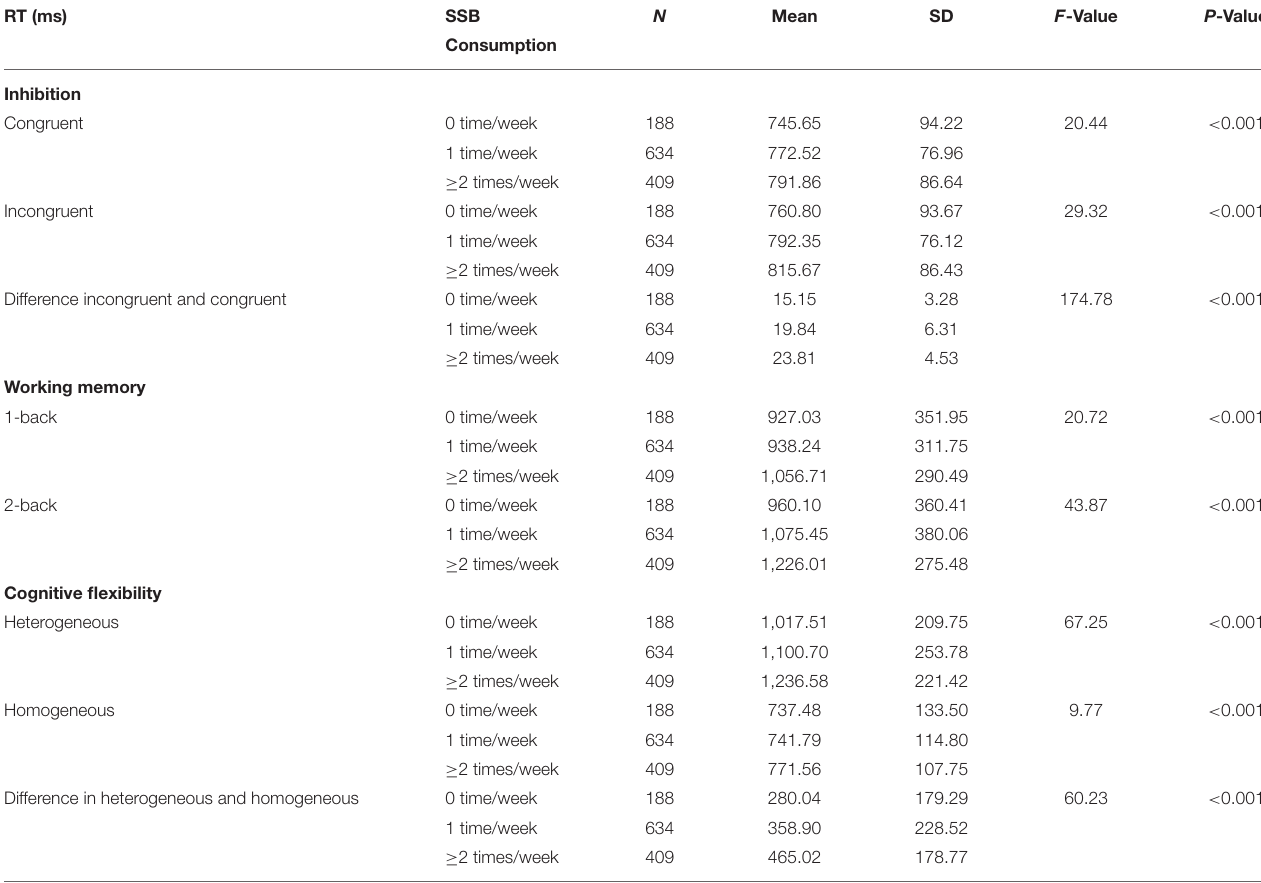
TABLE 2 | The status of executive function for Chinese Tibetan adolescents with different SSB consumption in Tibet of China. RT (ms) SSB N